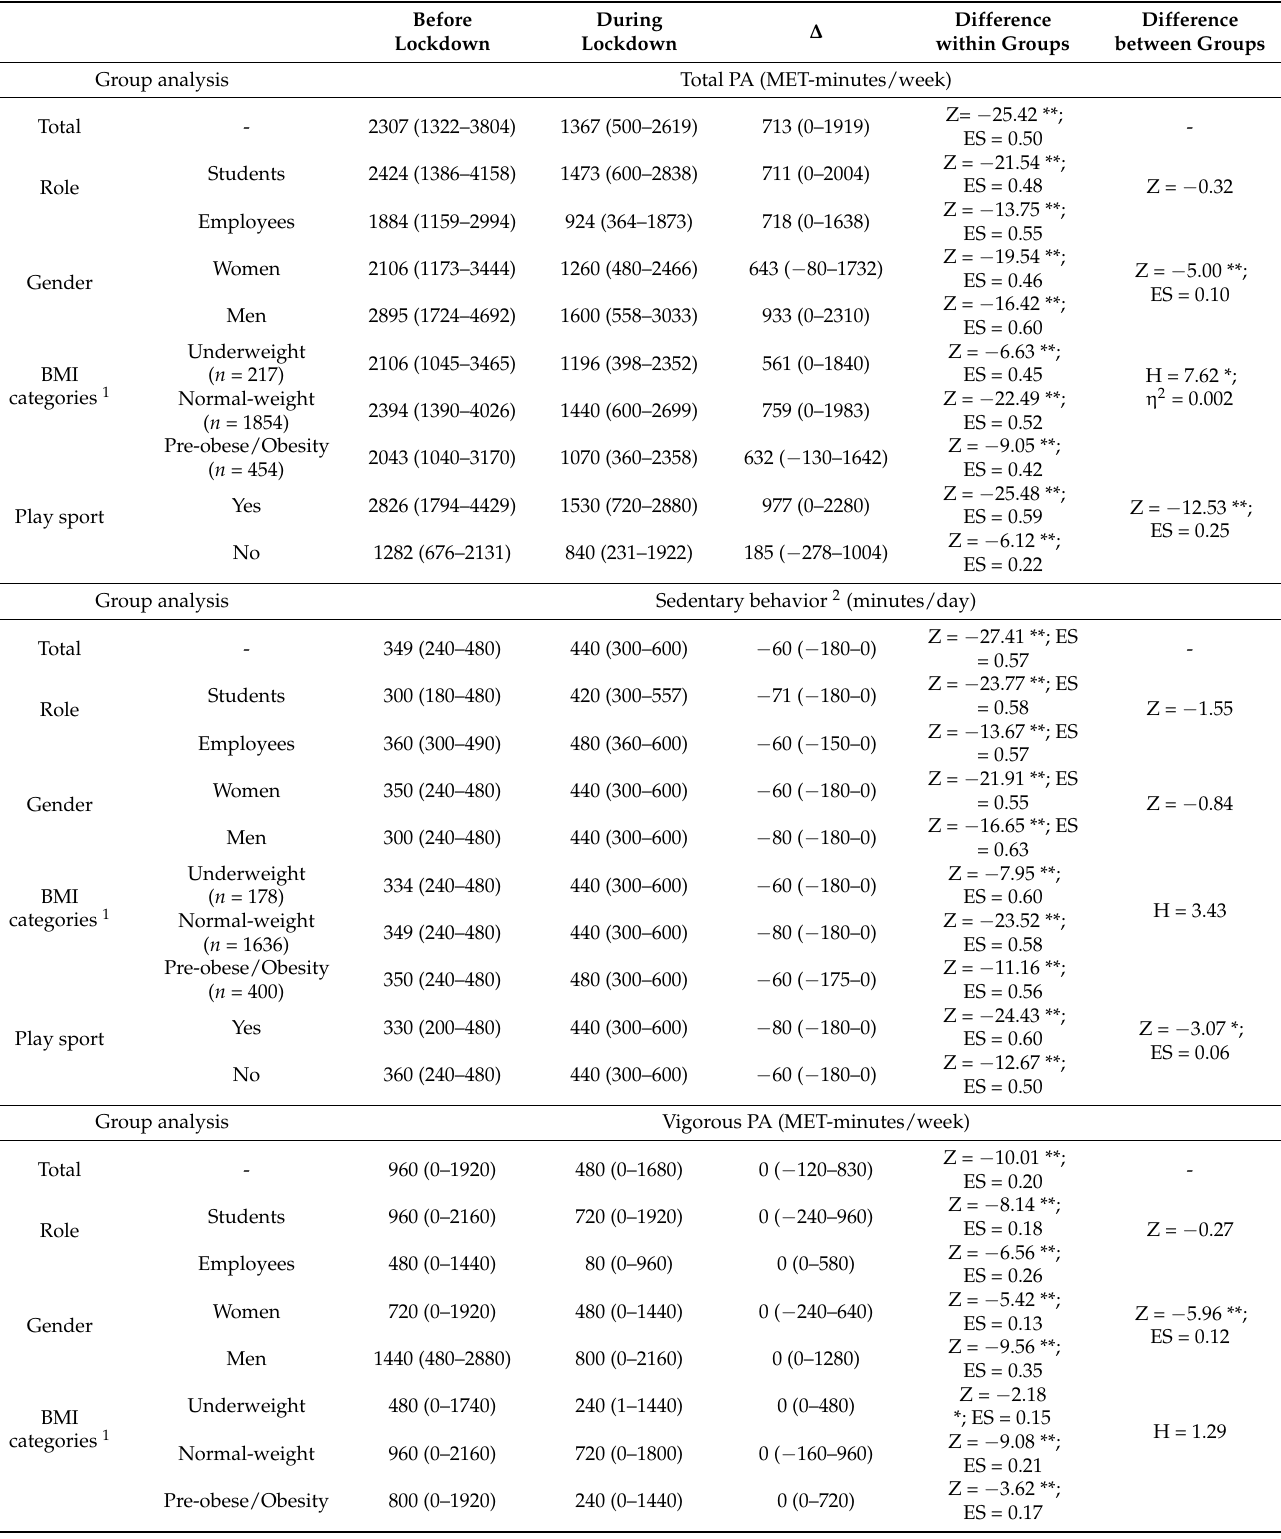
Table 3. Comparison of continuous IPAQ values before and during the lockdown (total PA, subtypes of PA, and sedentary